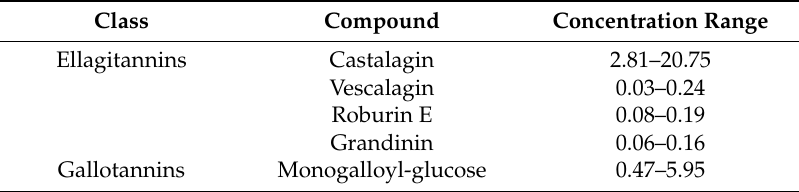
Table 2. Hydrolysable tannins found in aged wine